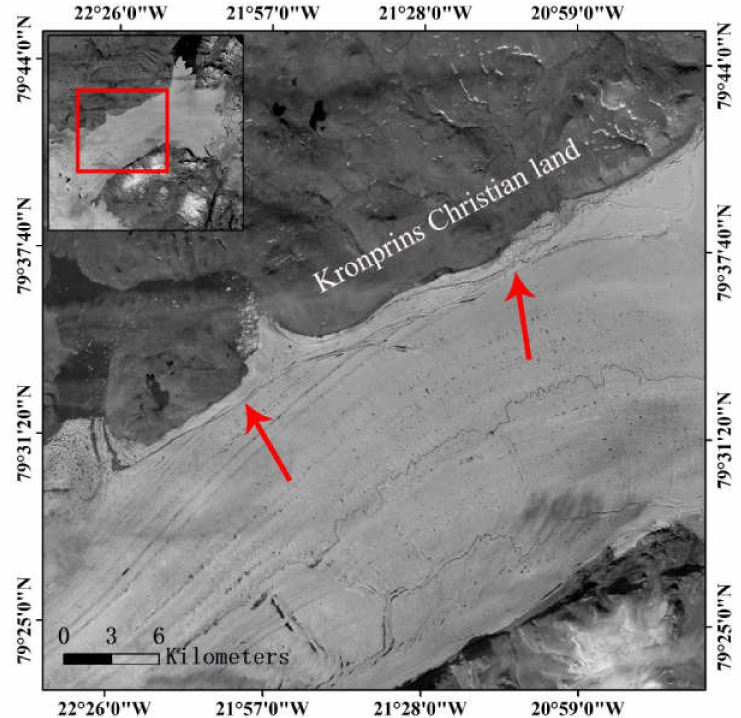
Figure 9. A portion of the 79NG Ice Shelf as shown in the 2012 Landsat imagery. The red arrows mark ocean-sourced basal channel.